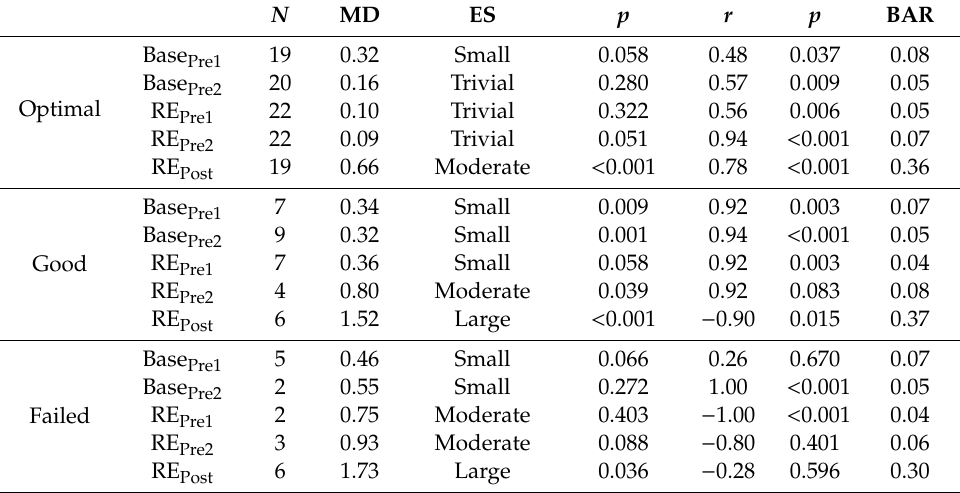
Table 2. Signal quality category-based comparative analysis.